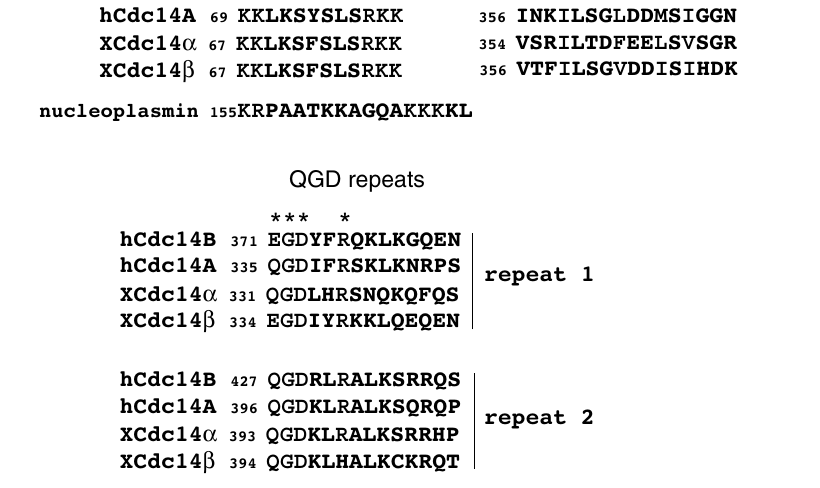
Figure 1 Primary Structure of Xenopus Cdc14 α and Cdc14 β phosphatases A. Schematic comparison of XCdc14 α , XCdc14 β and hCdc14A. The gray regions in hCdc14A correspond to the dual specificity phosphatase (DSP) domains identified in the crystal structure of hCdc14B. The nuclear export signal (NES), putative nuclear localization signal (NLS), and QGD repeats present in hCdc14A are conserved in XCdc14 α and XCdc14 β and are represented by shaded boxes. The asterisks represent the active site cysteines, and the circled "p" represents a canonical Cdk phosphorylation site (SPLK) located at residues 443– 446 of XCdc14 α . The solid lines at the bottom of the figure represent the regions of XCdc14 α that were used for immuniza- tions. Percentage identities between the subregions are indicated in grey. B. Alignment of the NLS, NES, and QGD sequences of hCdc14B, hCdc14A, XCdc14 α and XCdc14 β . Top left: hCdc14A, hCdc14B, XCdc14 α , and XCdc14 β contain putative bipartite NLS sequences that conform to the consensus motif (R/K) X (R/K) ,. The sequences are aligned with the bipartite 2 7–12 3 NLS from nucleoplasmin. Top right: Alignment of the NES sequences that are present in all four Cdc14 homologs. The NES of hCdc14A was shown to be functional by mutational analysis [21]. The " φ " in the consensus motif signifies hydrophobic amino acids. Bottom: Alignment of conserved C-terminal QGD